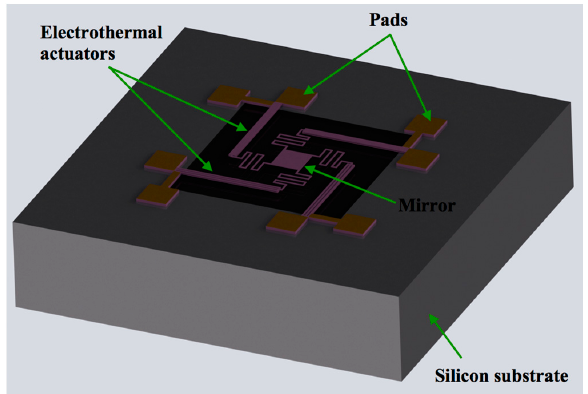
Figure 2. View of the MEMS mirror design in a silicon die.